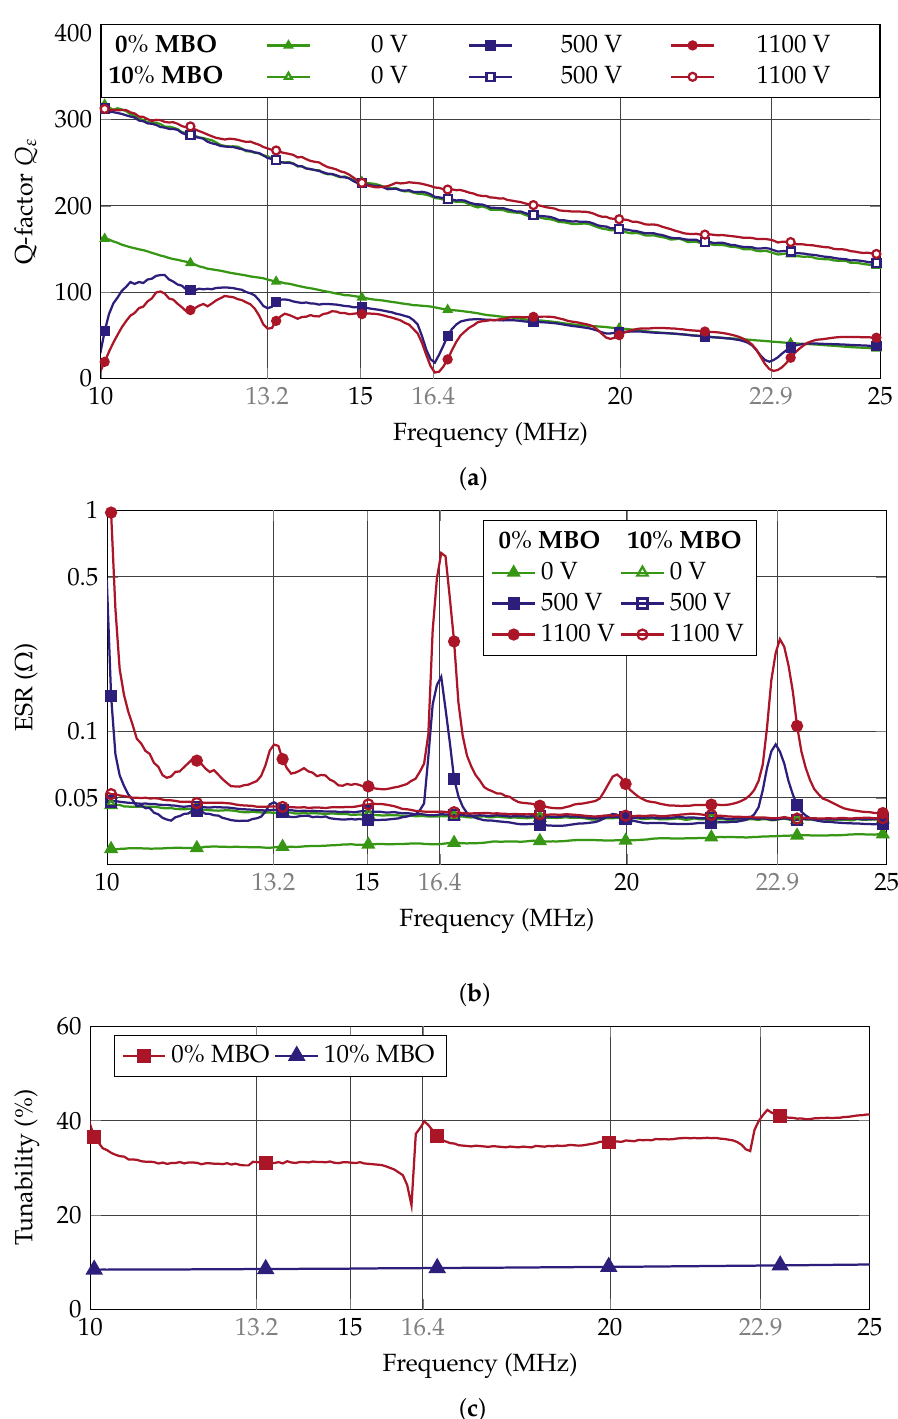
Figure 8. Extracted material values from measurements: ( a ) Q-factor, ( b ) ESR and ( c ) tunability at